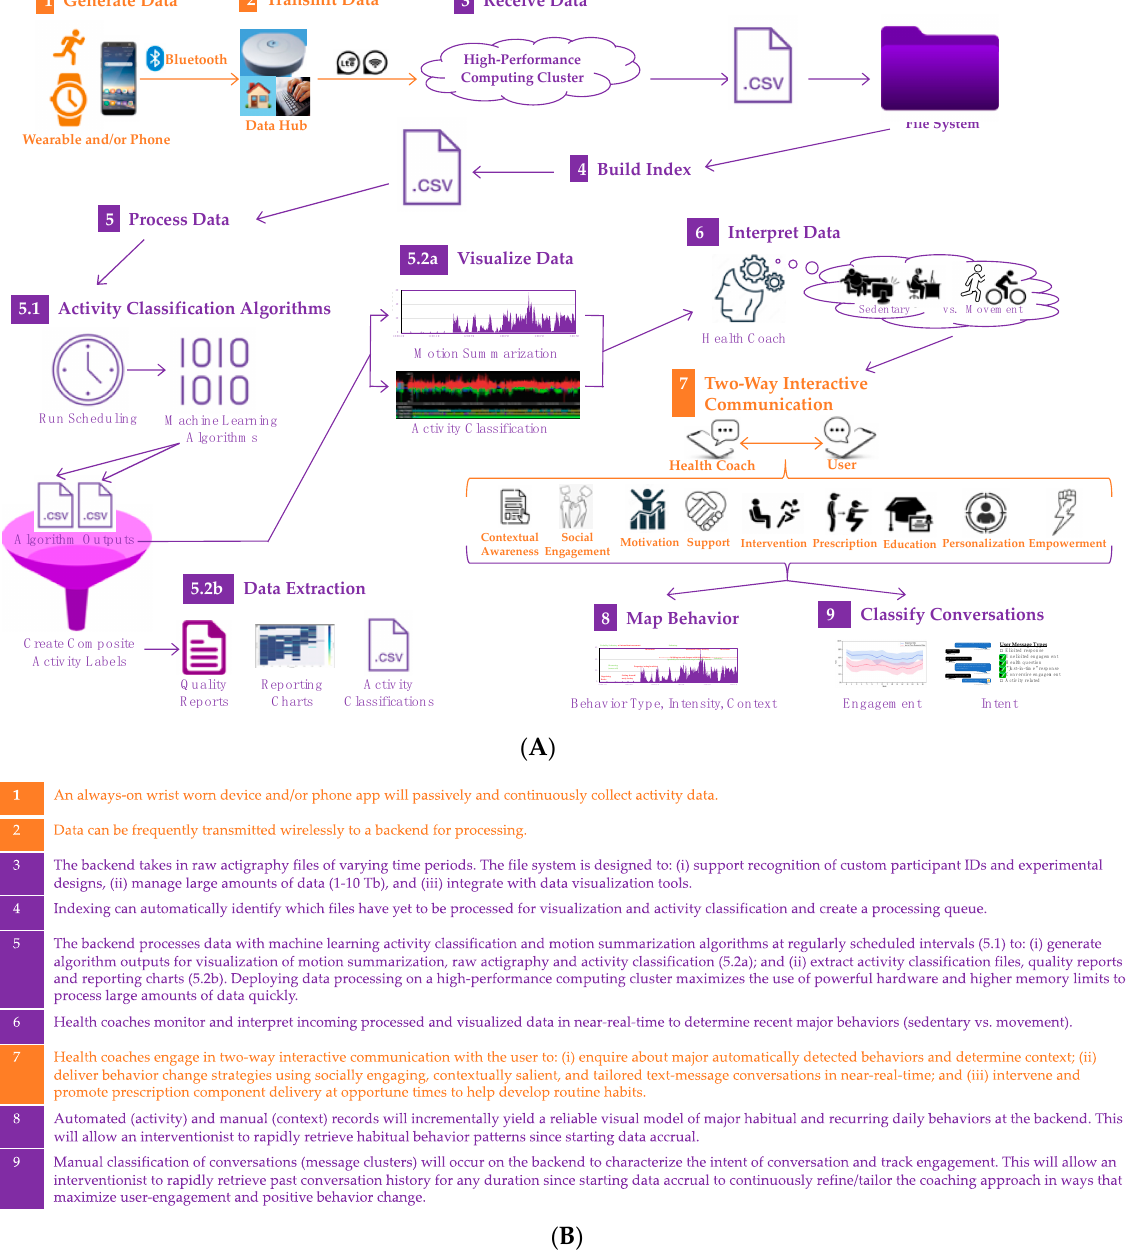
Figure 2. Conceptual model of Companion’s technical components, their integration, and function. ( A ) Flow diagram of the system’s components and their integration; ( B ) function of the system’s components.